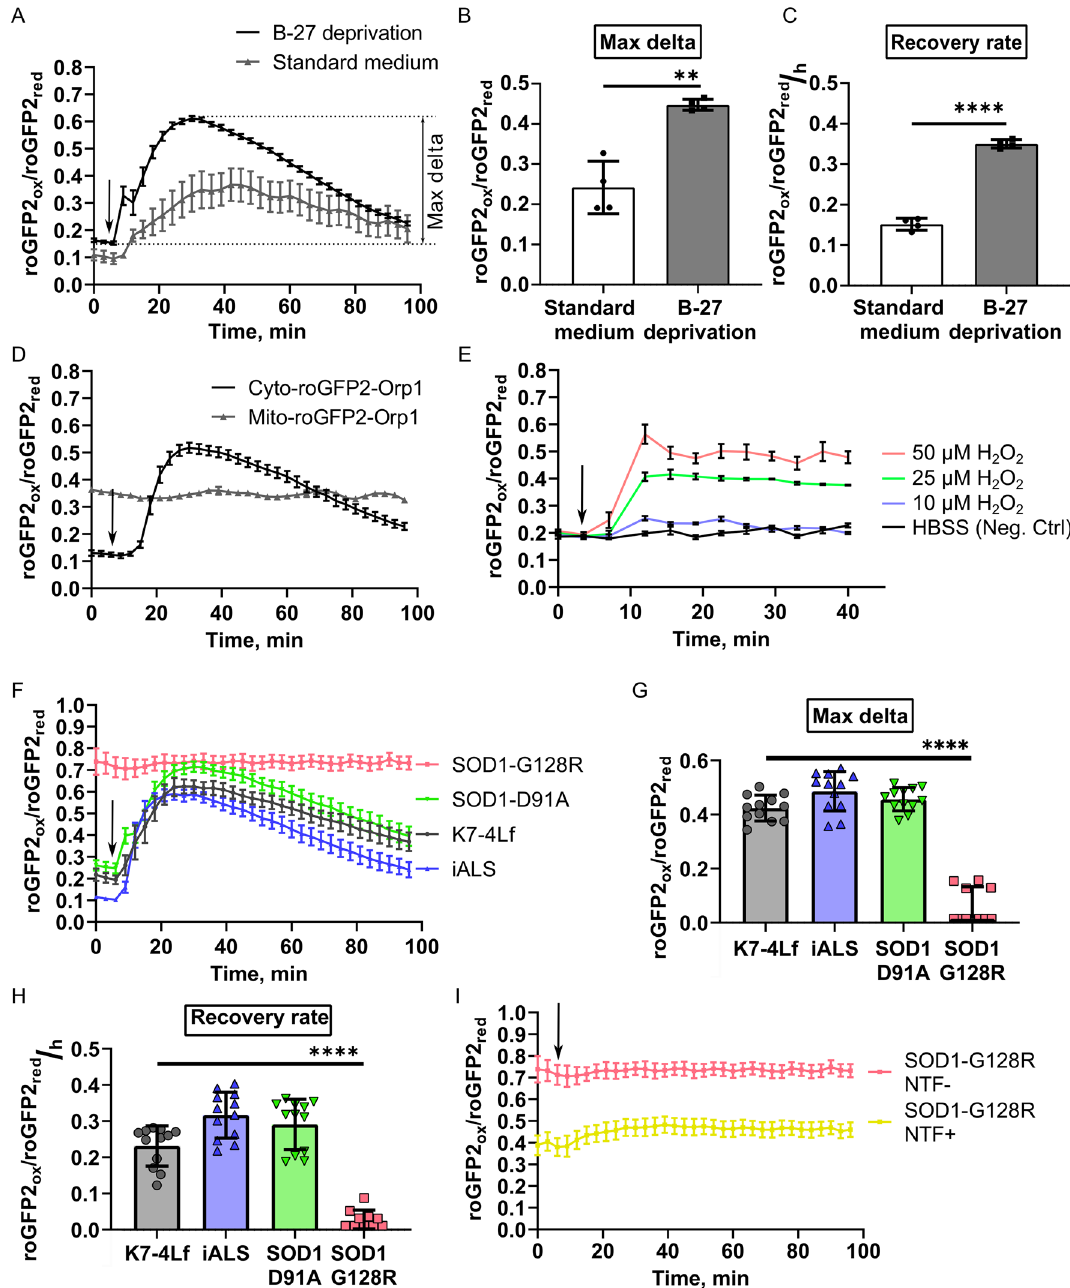
Figure 6. Kinetics of H 2 O 2 utilization in live iPSC-derived motor neurons (MNs). Values were obtained by analyzing the microscopic images of the respective MNs. ( A ) Response of the MNs, cultured in the standard or nutrient-deprived (without B-27) medium to addition of 10 μM H 2 O 2 . Data (N = 4 fields of view) are the mean ± standard error of the mean (S.E.M.). Max delta (difference between the maximum and initial level of oxidation, defined in panel A) of the cytoplasm oxidation ( B ) and recovery rate ( C ) of the MNs, expressing Cyto-roGFP2-Orp1, after H 2 O 2 addition. Data (N = 4 fields of view) are the mean ± standard deviation (S.D.) ( D ) Response of the MNs, expressing Cyto-roGFP2- Orp1 or Mito-roGFP2-Orp1, to addition of 10 μM H 2 O 2 . Data (N = 4 fields of view) are the mean ± S.D. ( E ) Response of the MNs, expressing Mito-roGFP2-Orp1, to the different H 2 O 2 concentrations. Data (N = 3 fields of view) are the mean ± S.D. ( F ) Response of the K7-4Lf, iALS, SOD1-D91A, and SOD1-G128R MNs, expressing Cyto-roGFP2-Orp1 to addition of 10 μM H 2 O 2 . Data (N = 12 fields of view, collected from MNs, derived from three iPSC lines with the same genotype) are the mean ± S.E.M. Max delta of the cytoplasm oxidation ( G ) and recovery rate ( H ) of the K7-4Lf, iALS, SOD1-D91A, and SOD1-G128R MNs, expressing Cyto-roGFP2-Orp1 after 10 μM H 2 O 2 addition. Negative values in the SOD1-G128R MNs were set to 0 on the graphs. Data (N = 12 fields of view, collected from MNs, derived from three iPSC lines with the same genotype) are the mean ± S.D. ( I ) Response of the SOD1-G128R MNs, expressing Cyto-roGFP2-Orp1 cultured in the standard medium (NTF−) or medium supplemented with neurotrophic factors (NTF+) to 10 μM H 2 O 2 . Data (N = 4 fields of view) are the mean ± S.E.M. The moment of the H 2 O 2 addition is marked by an arrow. **p < 0.01, ****p < 0.0001. Welch t-test for ( B ), and ( C ), one-way ANOVA with post hoc Dunnet’s tests for ( G ) and ( H ). The same dataset was used in Figs. 7F,I to represent the SOD1-G128R (− NTF) reaction to H 2 O 2